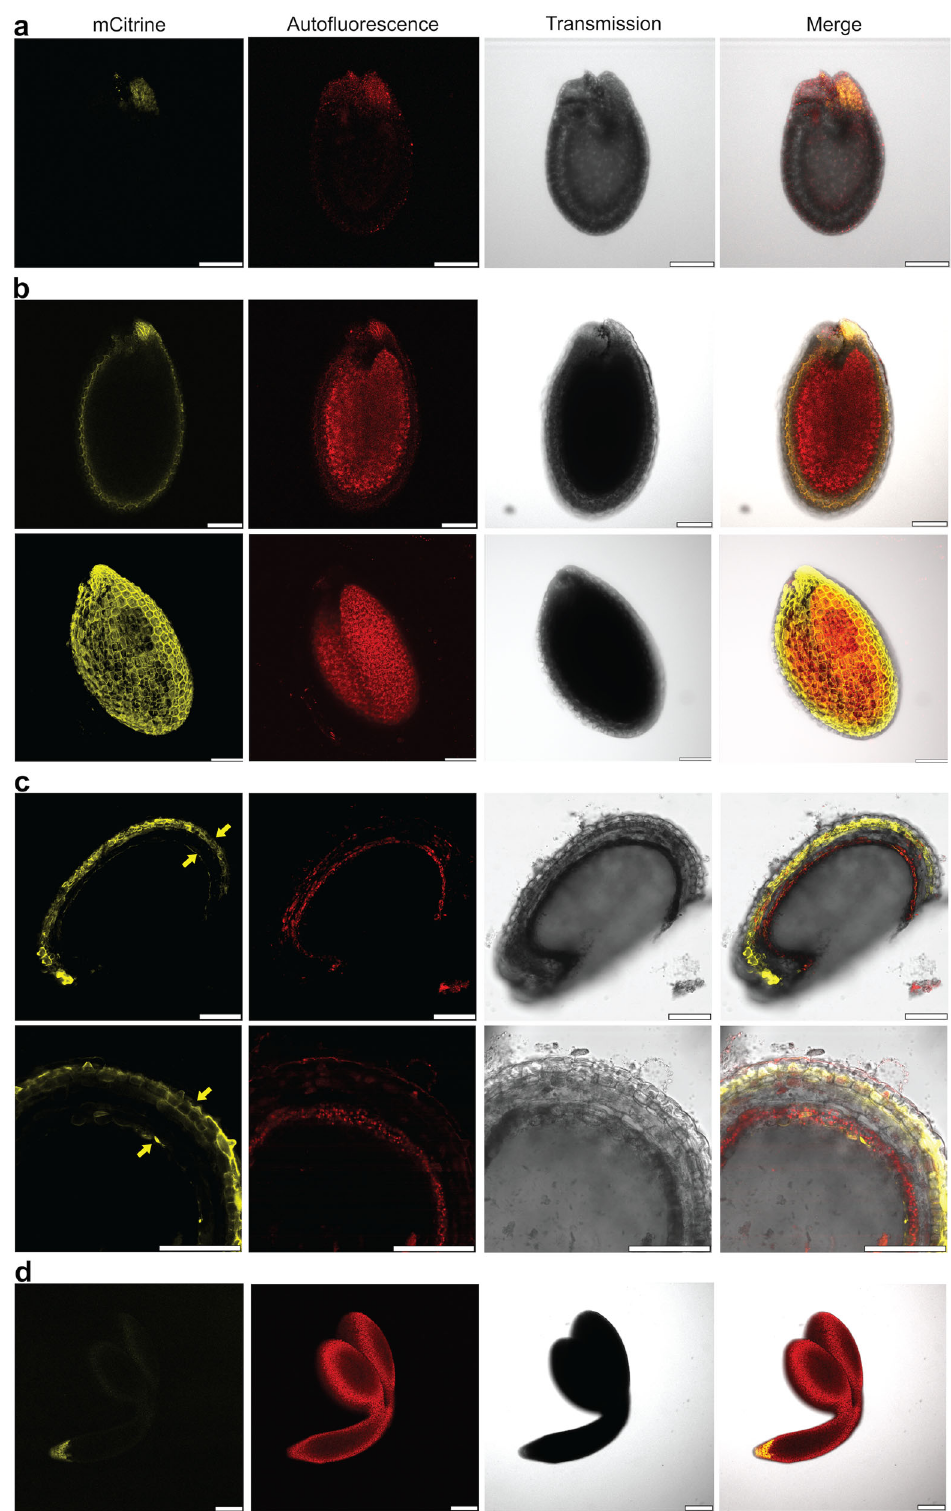
Fig. 7 AHA2 expression in developing seeds is con fi ned to the micropylar endosperm region, the outer seed coat, and the endothelium. Confocal images of AHA2 expression in developing mCitAHA2 seeds. Yellow: mCitrine-AHA2. Red: auto fl uorescence. Scale bar: 100 µ m. a Maximum intensity projection of AHA2 in early-developing seeds. AHA2 is expressed exclusively at the micropylar endosperm region. b Top panel: confocal image of an optical section of mature green seed. Bottom panel: maximum intensity projection of AHA2 distribution in mature green seed. The images show that at the mature stage AHA2 is highly expressed in the seed coat. c Confocal images of a mature green seed cut with a vibratome. Yellow arrows point to the endothelium and outer seed coat where AHA2 is expressed. d Confocal images of an embryo at the mature green stage show that AHA2 is expressed mostly in the